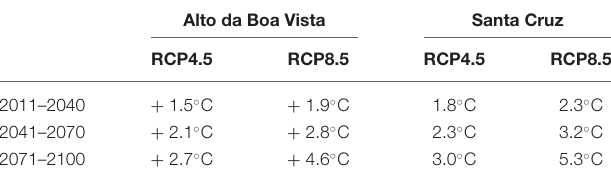
TABLE 6 | Precipitation projections for Rio de Janeiro, Brazil, over the 21st century, based on